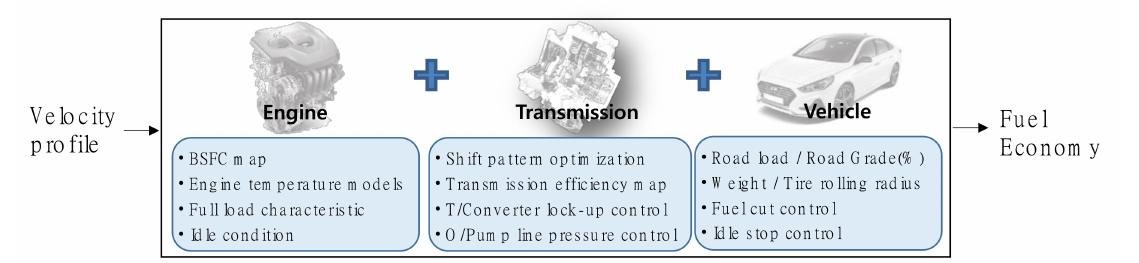
Figure 2. Fuel economy simulation program developed by the Hyundai motor company.